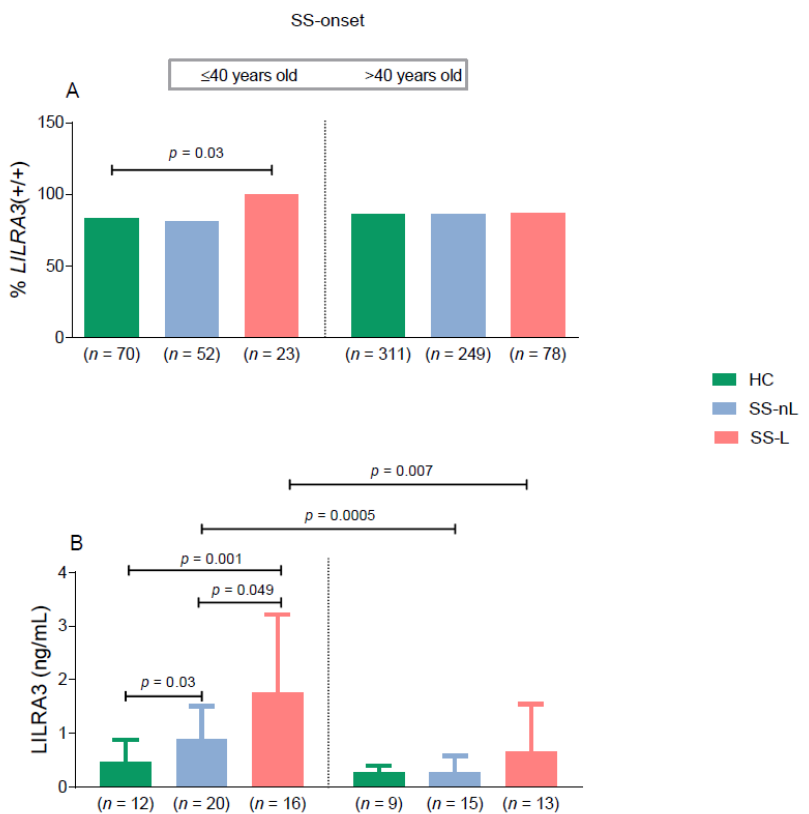
Figure 2. ( A ) Prevalence of the LILRA3 functional (wild) type variant (LILRA3+/+) in HC and distinct SS subgroups stratified by age of SS onset and lymphoma history. Statistically significant increased prevalence of the wild type LILRA3 variant in the SS-L subgroup with SS onset ≤ 40 years compared to HC. No statistically significant difference was detected in the frequency of the wild type variant among SS subgroups with SS onset >40 years and HC. ( B ) LILRA3 serum protein levels in SS patients and HC stratified by age of disease onset and the presence of lymphoma history. Statistically significant increased levels of LILRA3 protein serum levels were mainly observed in SS-L patients ≤ 40 years compared to HC. LILRA3: leukocyte immunoglobulin-like receptor A3; SS-nL: Sjogren’s syndrome non-lymphoma patients; SS-L: Sjogren’s syndrome lymphoma patients; HC: healthy controls. Only significant comparisons are shown.